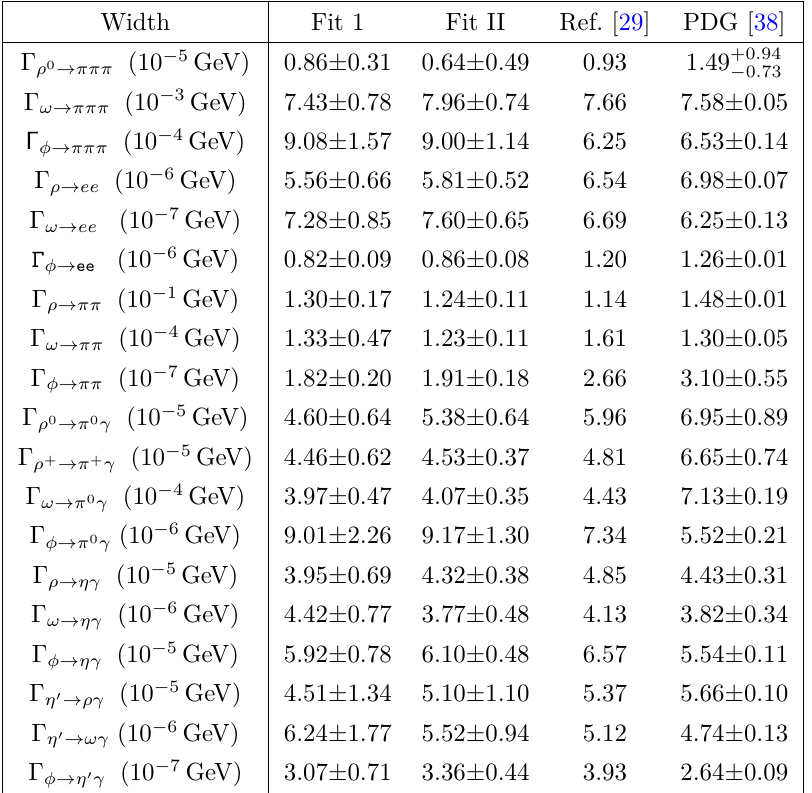
Table 1 . Decay widths involving vector resonances compared with the Fit 4 of ref. [29] and PDG